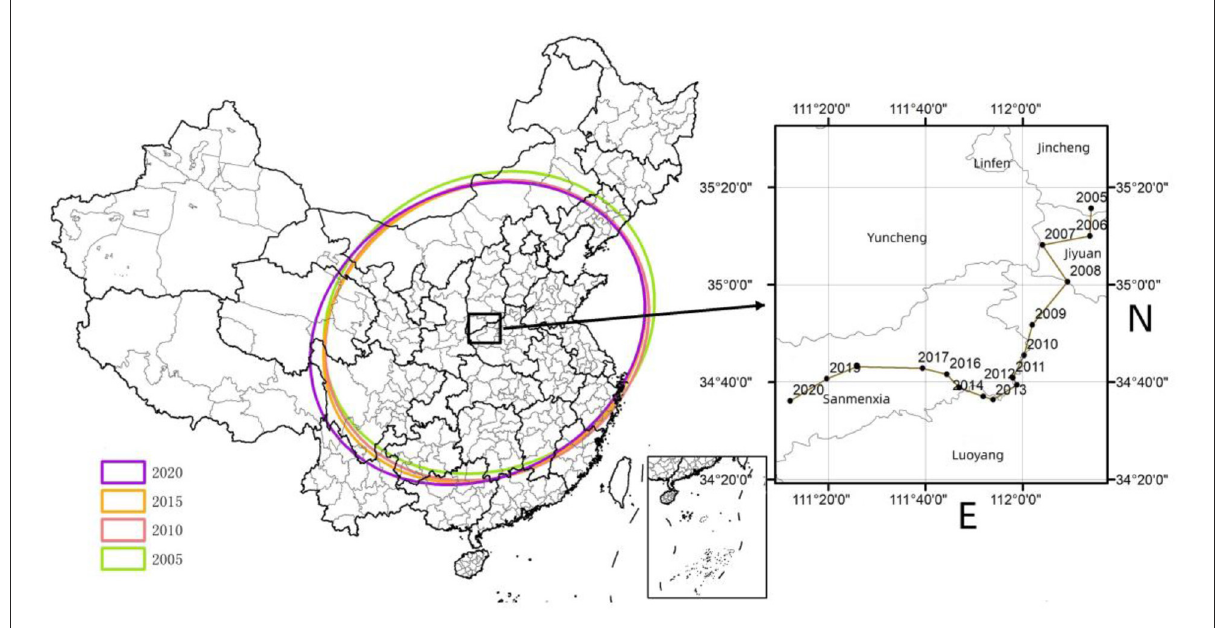
FIGURE5 The migration trajectory of the center of the MHSS level in